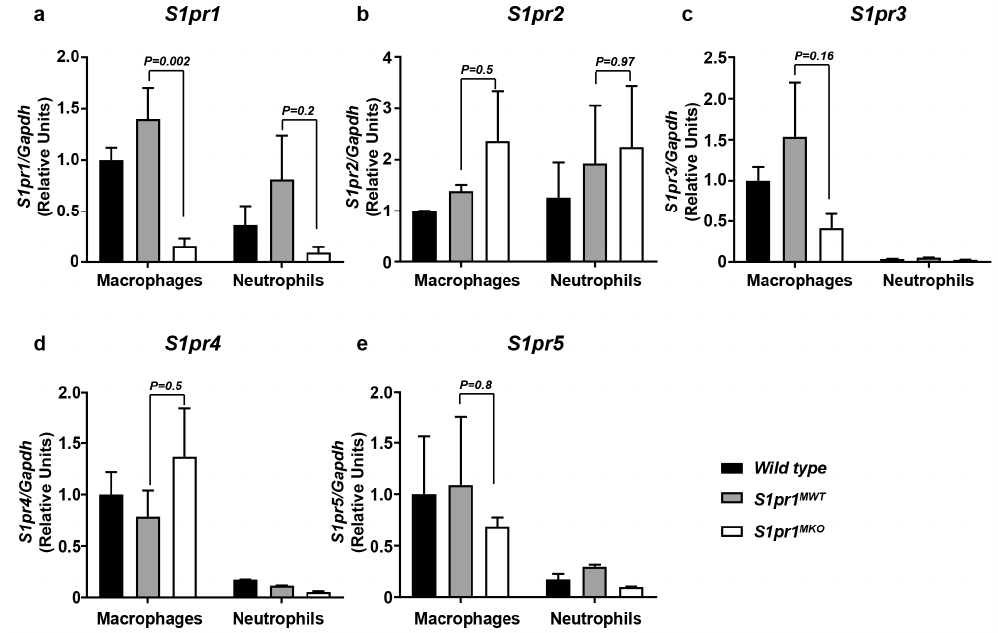
Figure 1. S1pr1 , 2 , 3 , 4 and 5 gene expression in macrophages and neutrophils from S1pr1 MKO mice. Thioglycollate-elicited peritoneal macrophages or neutrophils were harvested from wild-type ( WT ) C57BL6/J (black bars), S1pr1 MWT (grey bars) and S1pr1 MKO mice (white bars) and RNA extraction and